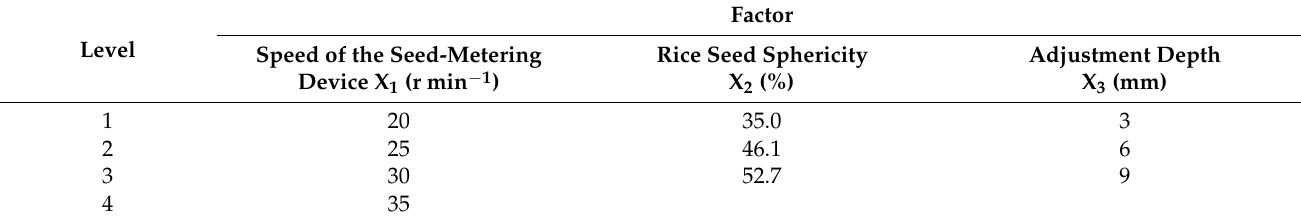
Table 2. The levels of the experiment